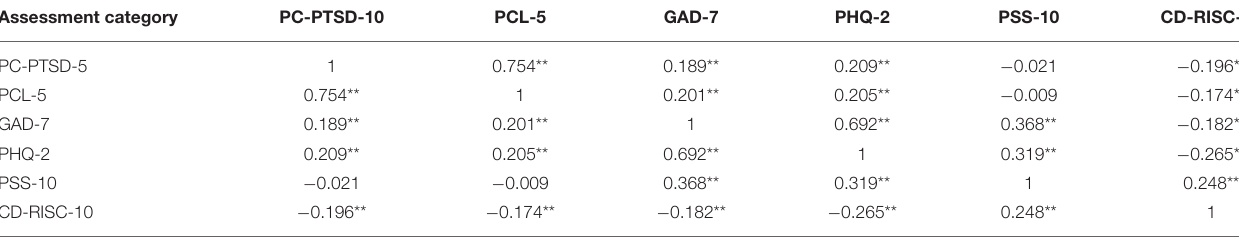
TABLE 4 | Correlations between PCL-5, GAD-7, PHQ-2, PSS-10, CD-RISC-10 and PC-PTSD-5.